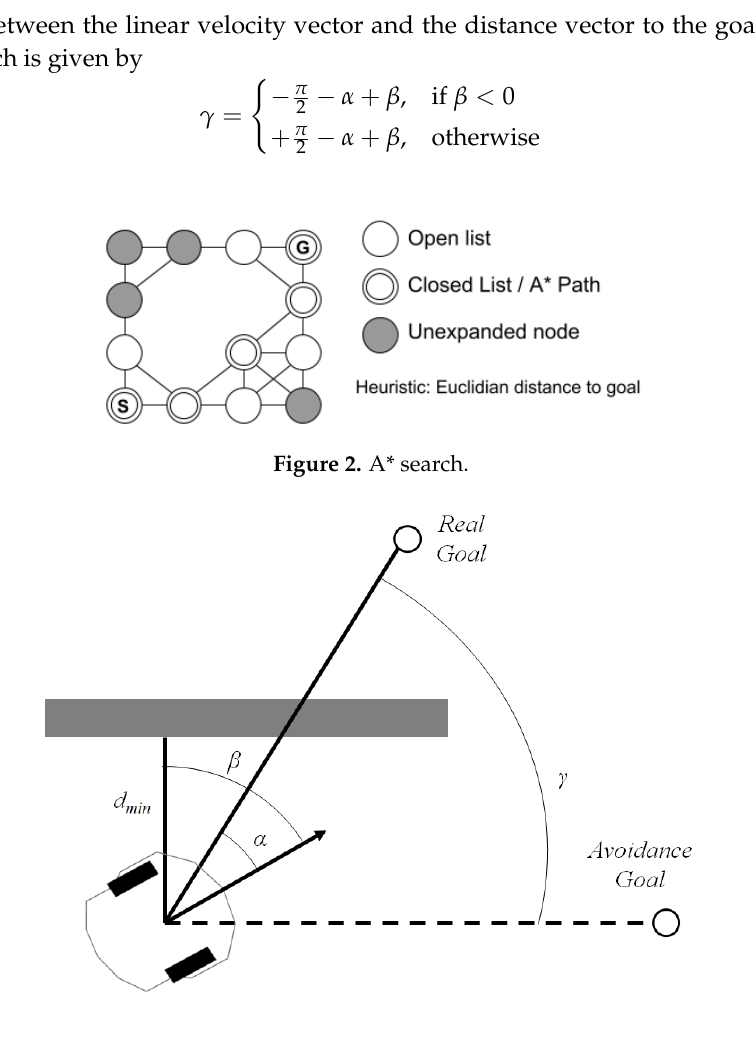
Figure 3. Tangential escape